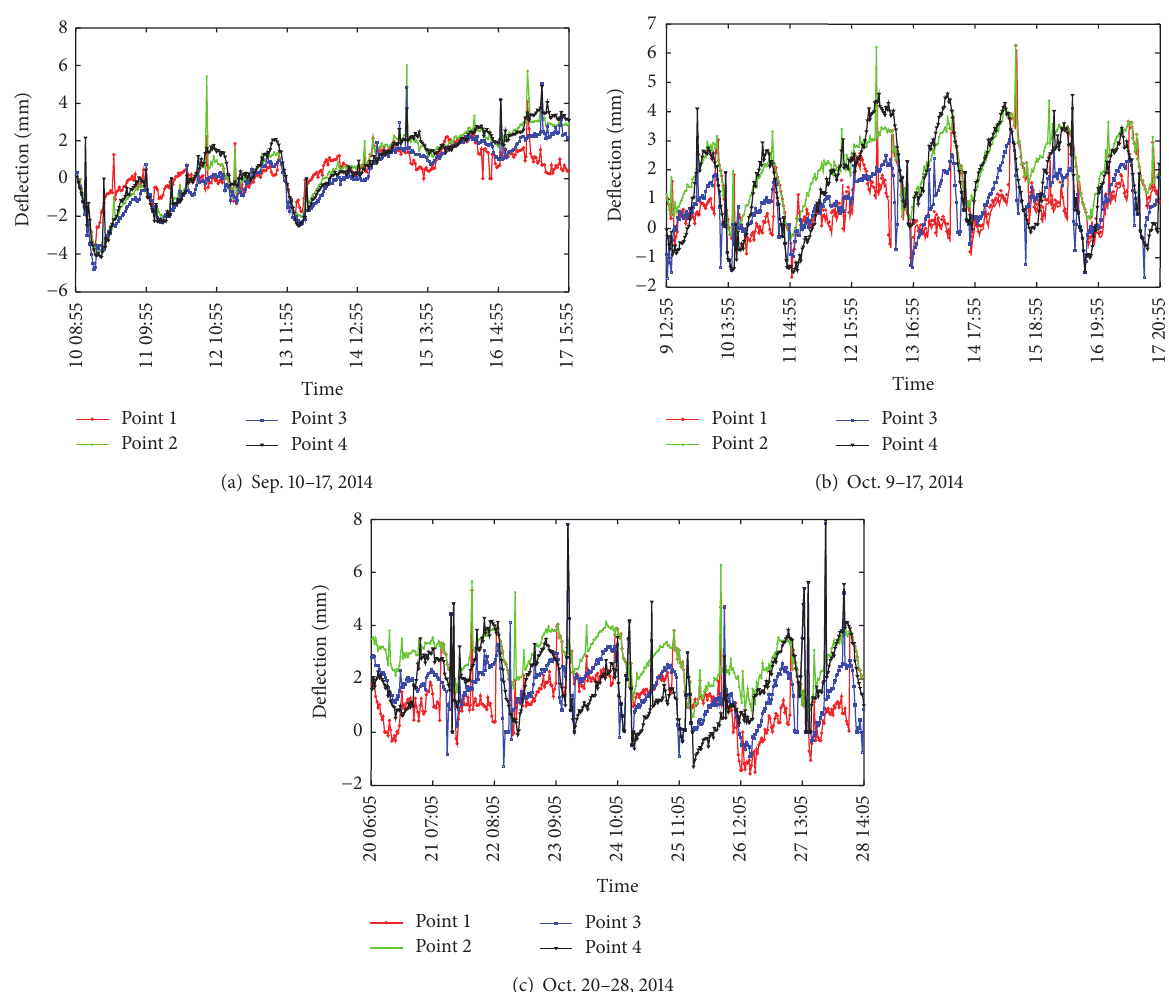
Figure 13: In situ deflection curves of Songjiazhuang cloverleaf